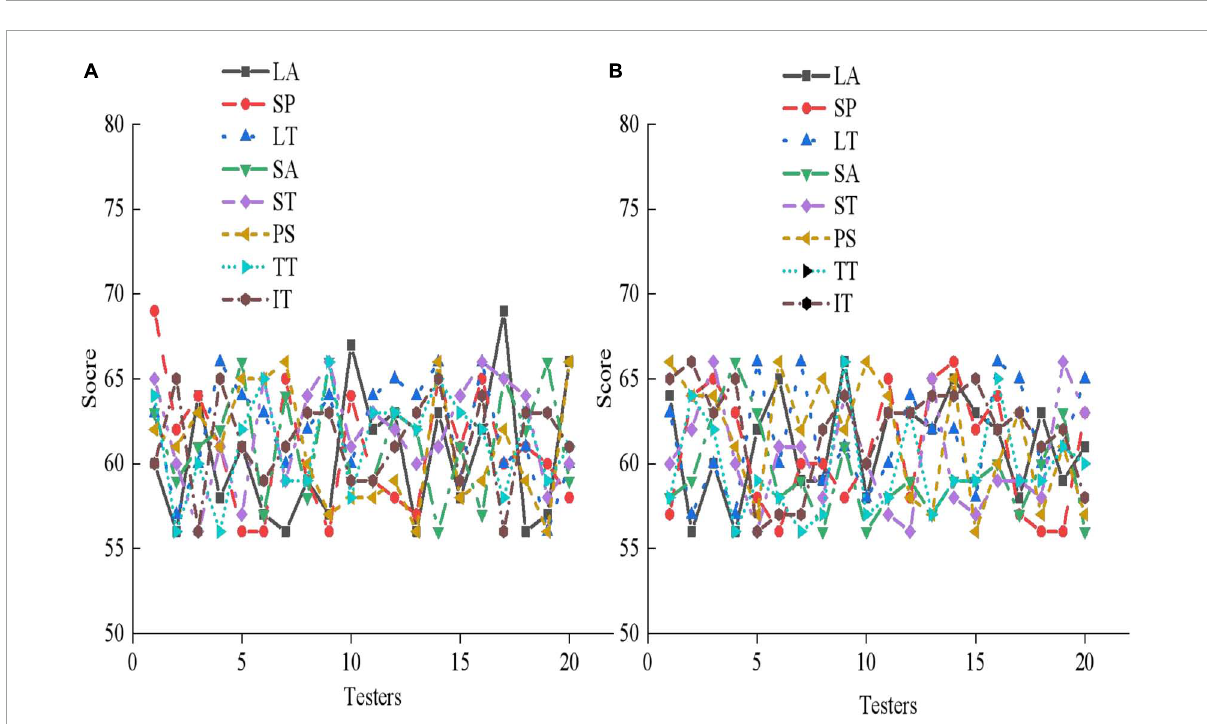
FIGURE11 Pre-experiment mental health assessment of 40 adolescent subjects. (A) The experimental group; (B) the control